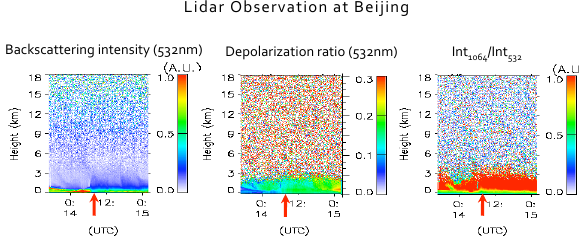
Fig. 12. Lidar observation at Beijing by NIES lidar from 14:00UTC to 15:00UTC on 14 April 2004. The left panel, center panel, and right panel show backscattering intensity at wavelength 0.532µm, depolarization ratio at wavelength 0.532µm, and the color ratio of scattering intensities at λ = 1 . 064µm and 0.532µm, respectively. The arrows indicate the time that we checked the SKYNET data (14 April 2004,